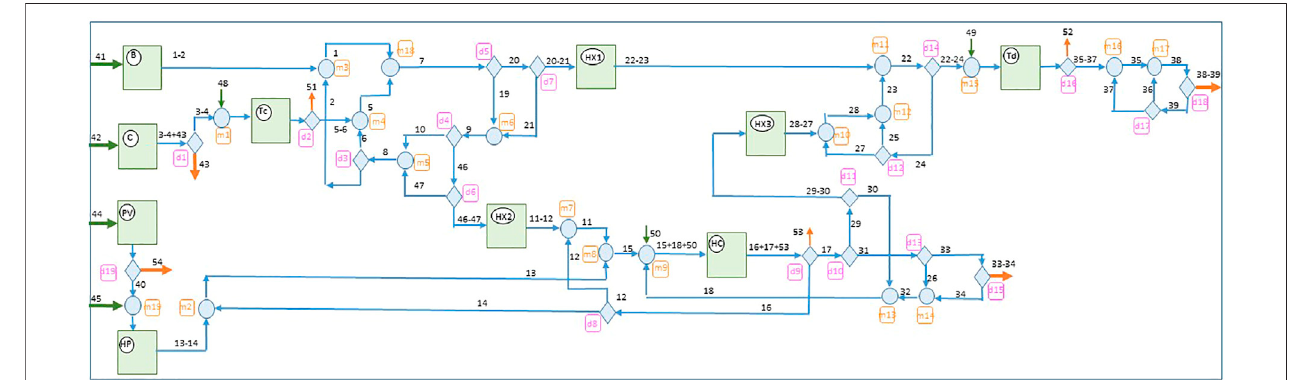
FIGURE 6 | Productive Super-structure of the thermal system according to the fl ows numbering of Figure 5 .